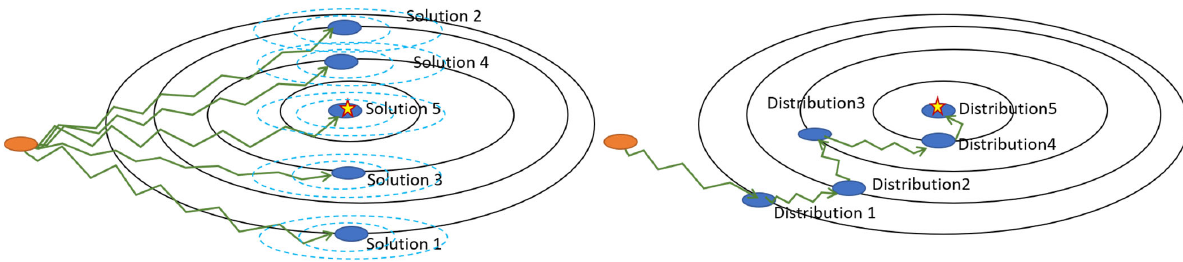
Figure 1. Comparison between the conventional MAP ( left ) and the proposed joint-parameter- Bayes ( right ).